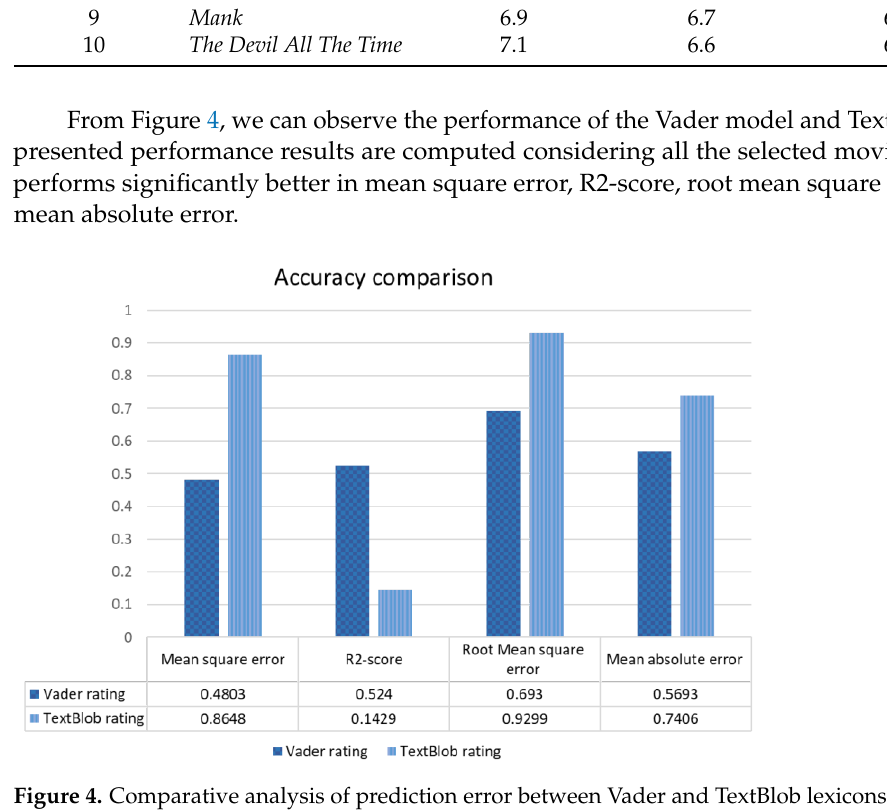
Figure 4. Comparative analysis of prediction error between Vader and TextBlob lexicons. Figure 5 plotted the IMDb rating, Vader, and TextBlob predicted ratings for